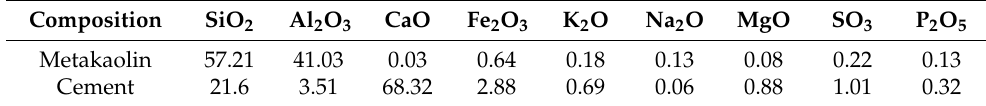
Table 1. Chemical Compositions of Cementing Materials in the Test(%).